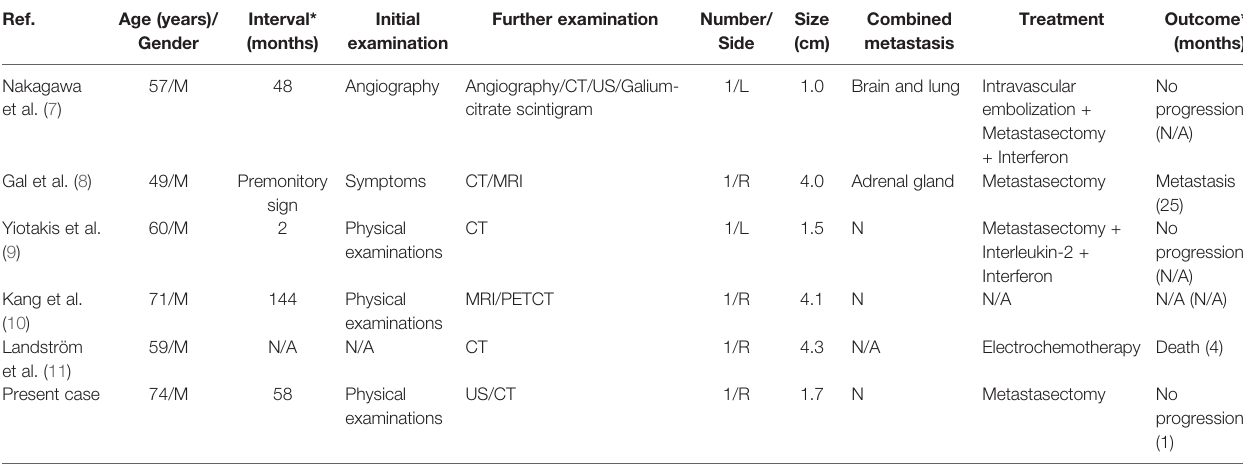
TABLE 1 | Clinical characteristics of cases with masseter muscle metastasis of RCC.